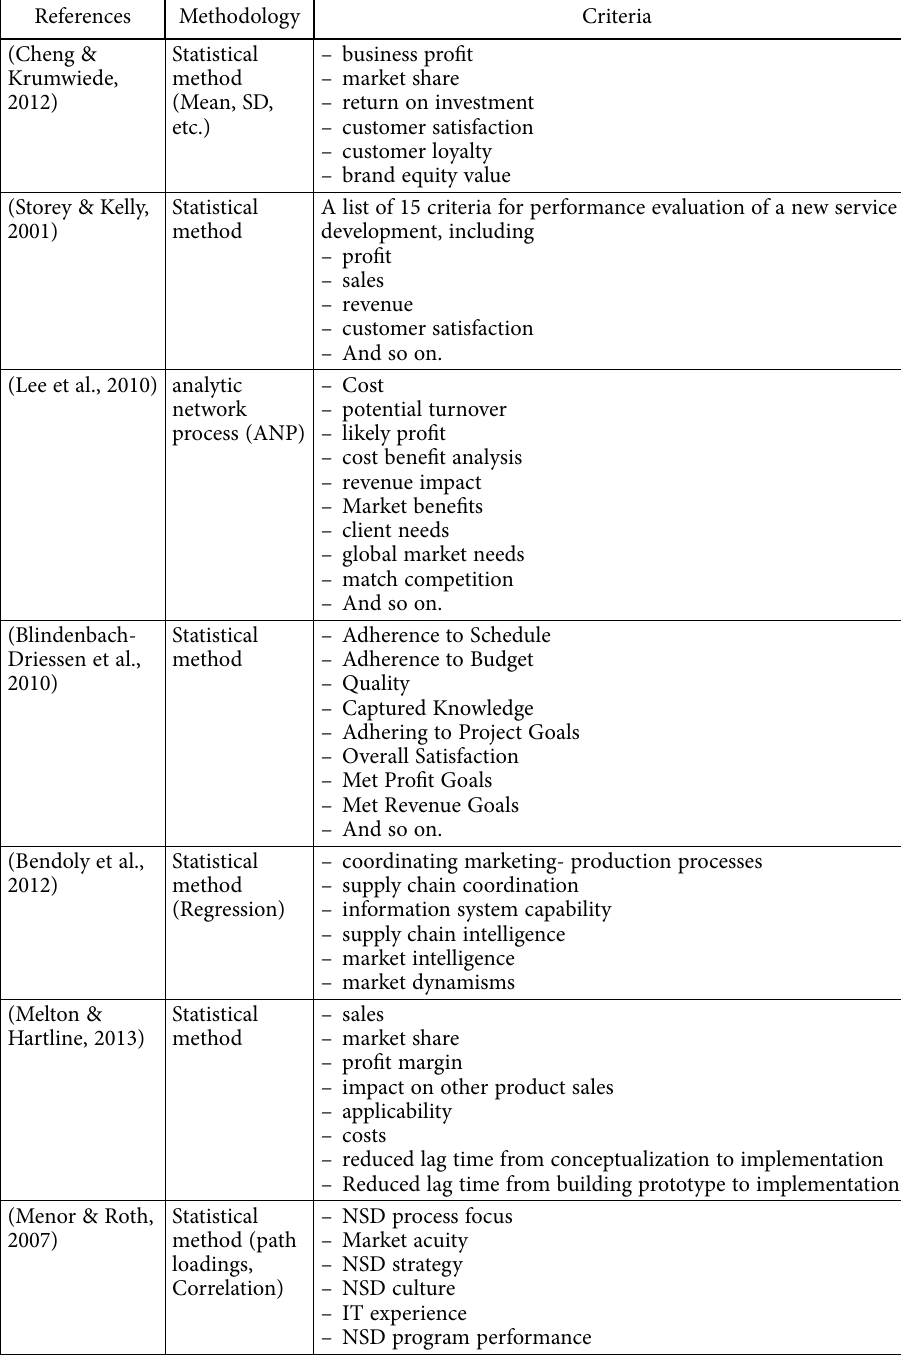
Table 1. Literature review (methods and